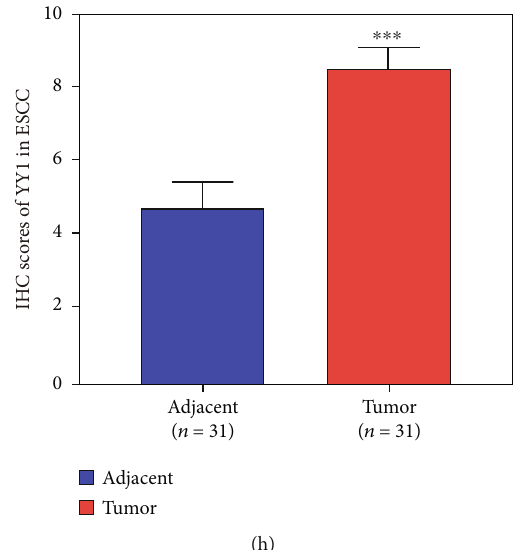
Figure 1: The expression of YY1 in ESCA and its relationship with prognosis of ESCA patients. (a) Expression of YY1 in di ff erent tumors. (b) Expression of YY1 in ESCA based on sample types. (c) The diagnostic value of YY1 in ESCA patients was demonstrated by ROC curve. (d) The mRNA expression of YY1 in ESCC cell line and normal esophageal epithelial cell line. (e) The mRNA expression of YY1 in 31 pairs of ESCC cancer tissues and matched adjacent tissues. (f) The protein expression of YY1 in ESCA cancer tissues and matched adjacent tissues. (g) Representative IHC images of YY1 staining in ESCC tumor or adjacent tissues (scale bar, 100 μ m; magni fi cation, 100x and 200x). (h) IHC scores of YY1 in ESCA cancer tissues and matched adjacent tissues. ∗ P < 0 : 05 , ∗∗ P < 0 : 01 , and ∗∗∗ P < 0 : 001 . ROC: receiver operating characteristic; AUC: area under curve; A: adjacent tissue; T: tumor